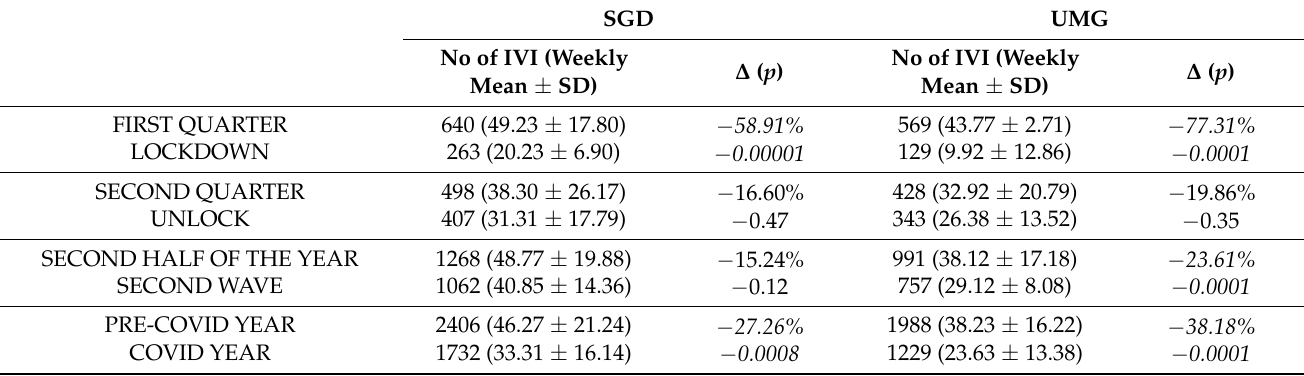
Table 1. Number of intravitreal-injection procedures performed at San Giovanni di Dio (SGD), University of Cagliari and Mater Domini, University Magna Græcia of Catanzaro (UMG). Note: statistically significant values are in italics.